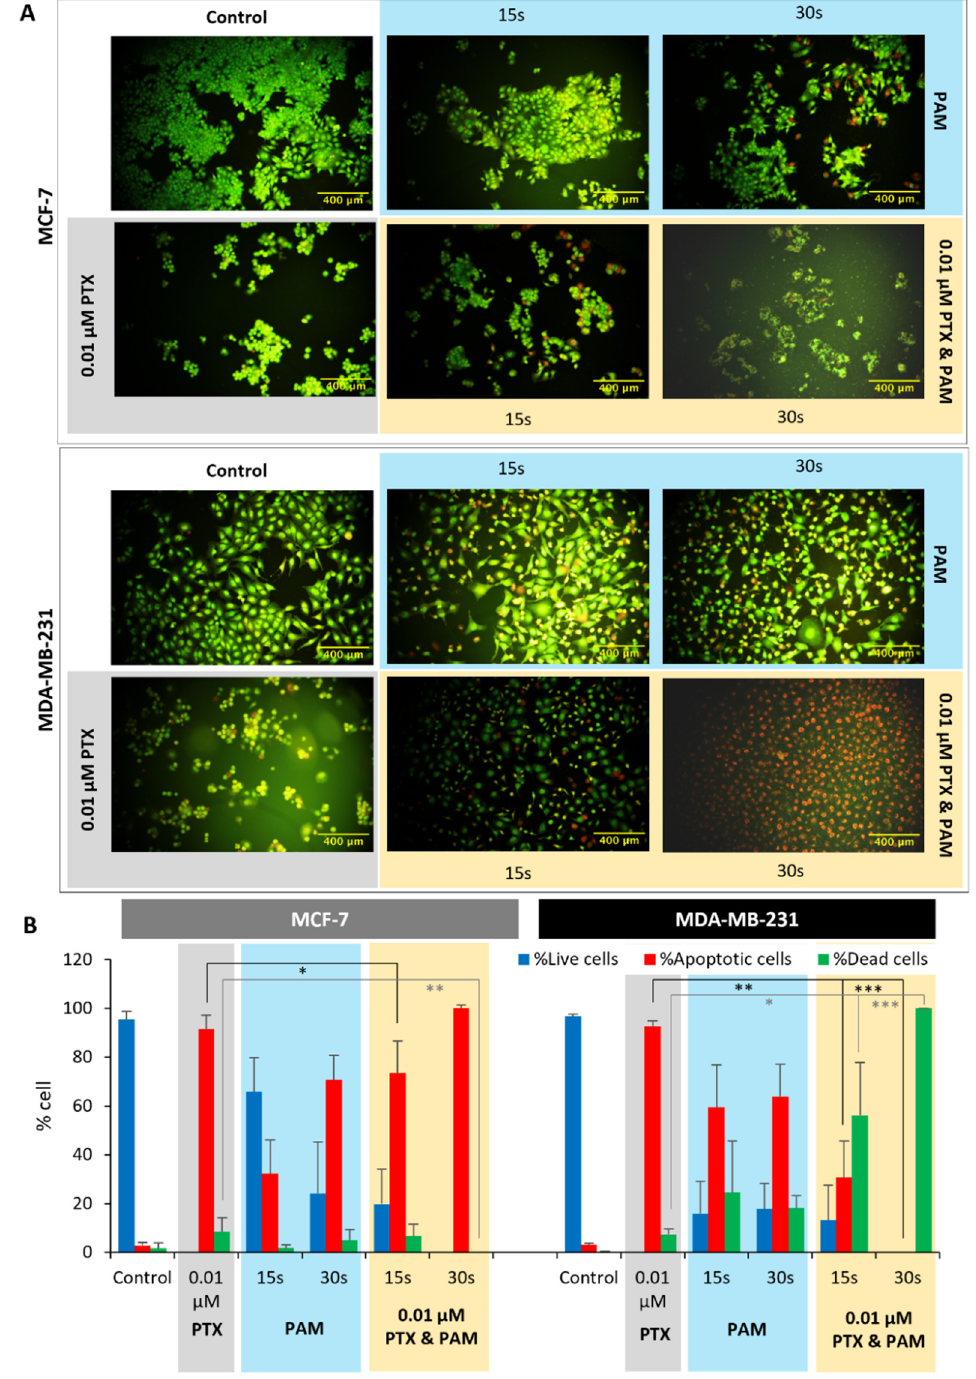
Figure 5. Apoptosis assessment of MCF-7 and MDA-MB-231 cells treated with PAM and PTX. ( A ) Representative images of MCF-7 and MDA-MB-231 under the effect of PTX, combined treatment, and PAM. Untreated cells were cultivated in normal DMEM, without addition of any treatment. PTX-treated cells presented changes in morphology and an increased frequency of apoptotic (condensed green nucleus or orange chromatin) and dead cells. In 0.01 µM PTX and PAM 15 s and 0.01 µM PTX and PAM 30 s groups, the frequency of apoptotic and dead cells significantly increased. PAM 15 s and PAM 30 s showed less frequency of apoptotic and dead cells. ( B ) Distribution of the live, dead, and apoptotic (early and late apoptotic cells) populations (%) of MCF-7 and MDA-MB-231 cell cultures. Data are mean and SEM values ( n = 3). * p < 0.05; ** p < 0.01; *** p < 0.001 (ANOVA).